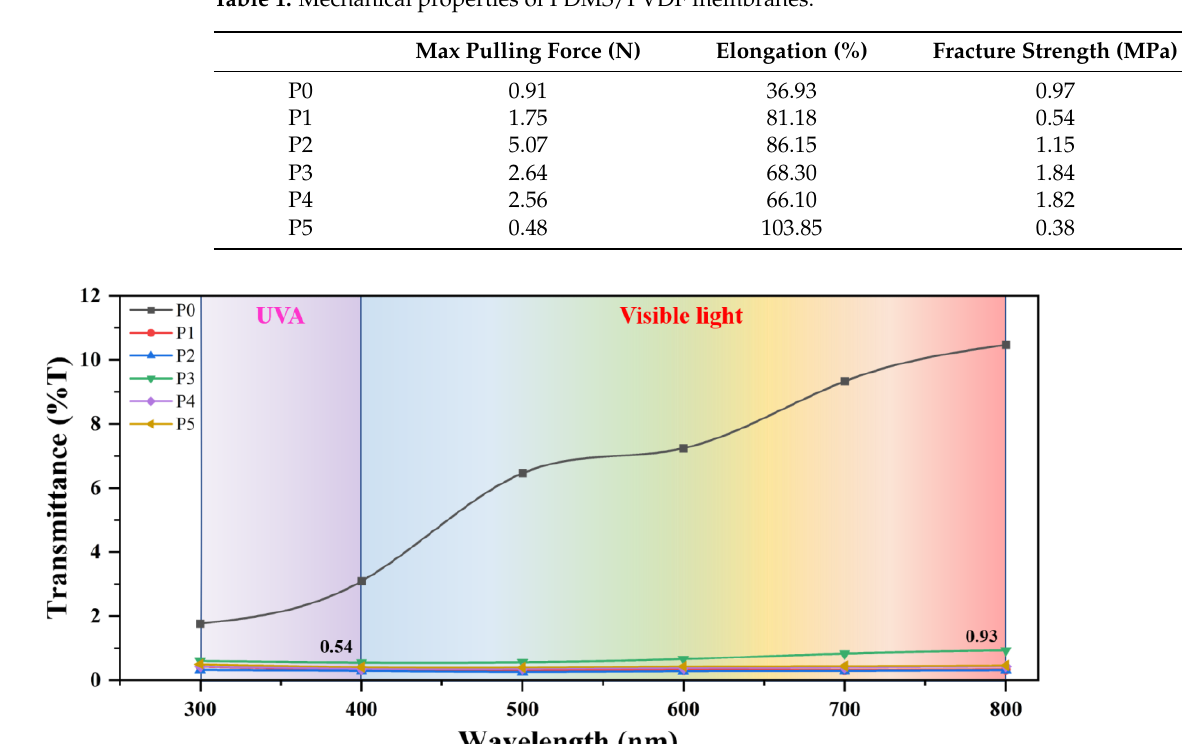
Table 1. Mechanical properties of PDMS/PVDF membranes.